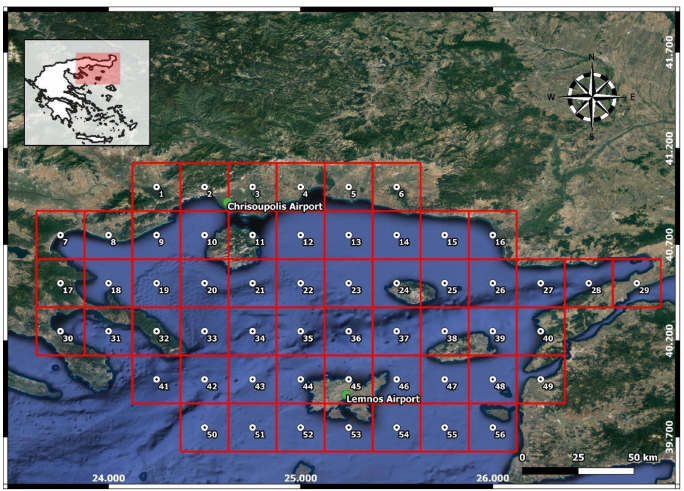
Figure 1. Study area map and CMEMS grid